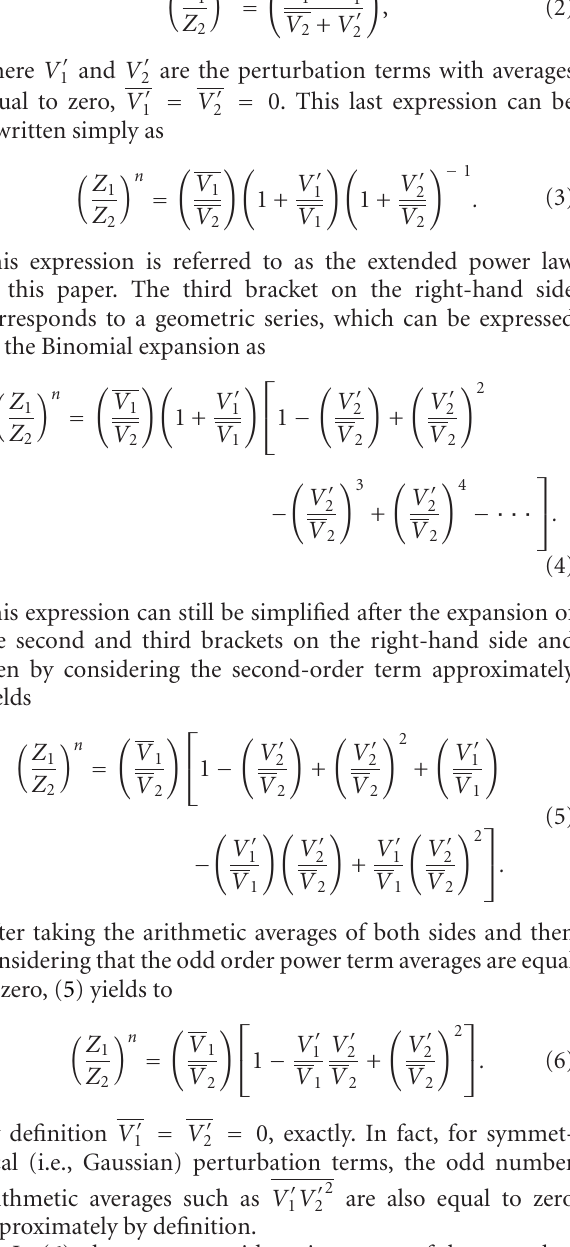
Table 1: Wind shear coe ffi cient of various terrains [3]. Terrain type Lake, ocean, and smooth-hard ground 0.1 Foot-high grass on level ground 0.15 Tall crops, hedges, and shrubs 0.2 Wooded country with many trees 0.25 Small town with some trees and shrubs